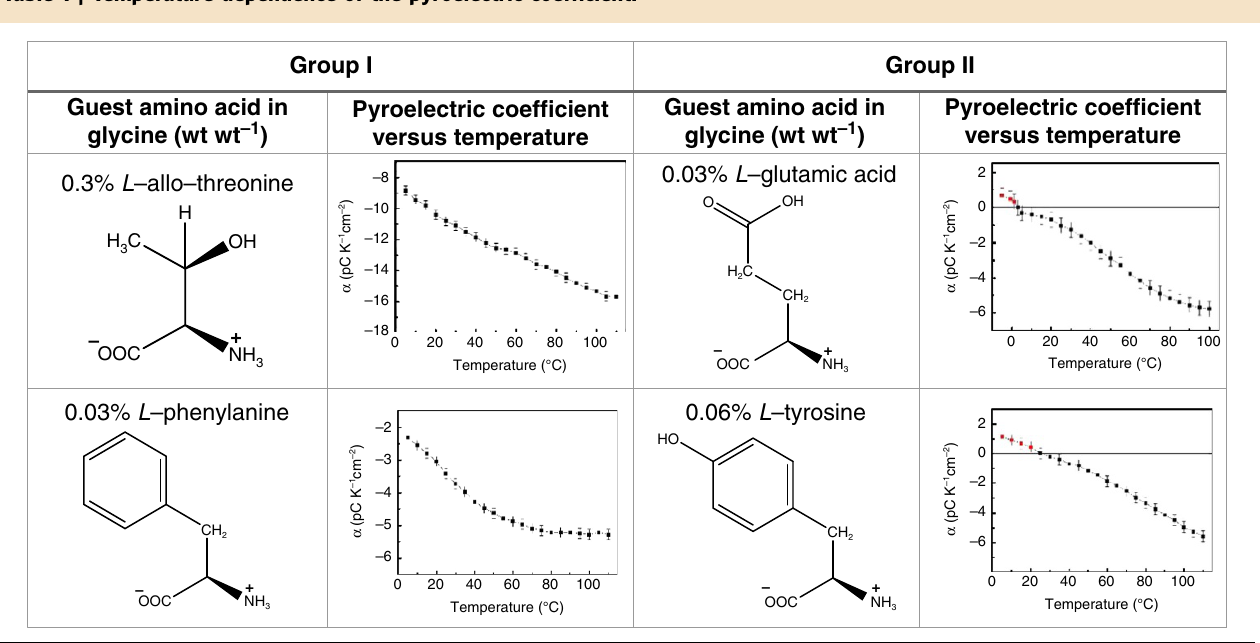
In Table 2 of this Article, the graph displaying ‘Pyroelectric coefficient versus temperature’ for 0.03% L -phenylalanine incorrectly replicates the graph above. The correct version of Table 2 appears below as Table 1. Table 1 | Temperature dependence of the pyroelectric coefficient. Group I Group II Guest amino acid in Guest amino acid in Pyroelectric coefficient )Pyroelectric coefficient glycine (wt wt –1 ) glycine (wt wt –1 versus temperature versus temperature 0.3% L –allo–threonine